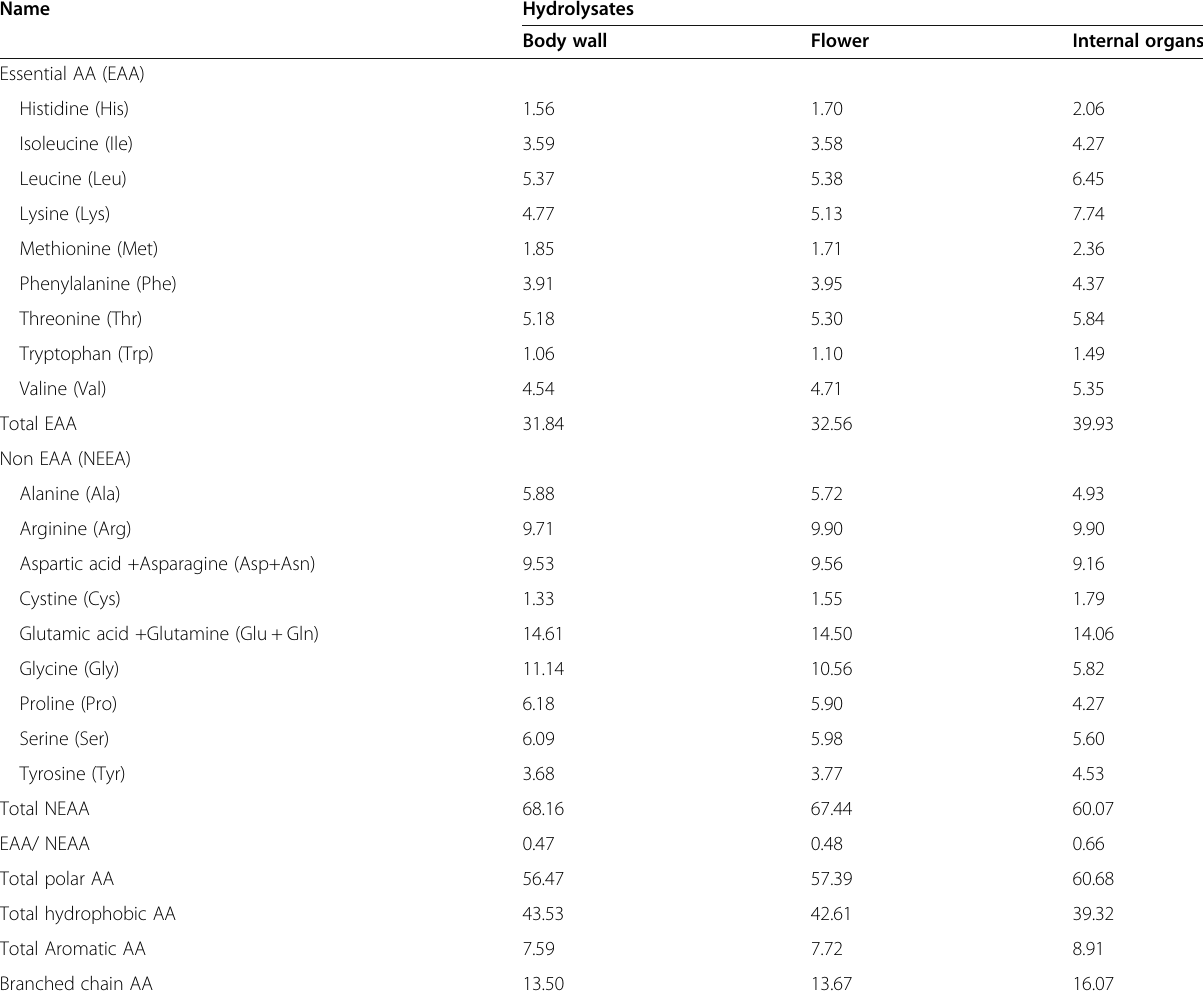
Table 3 Amino acid composition of protein hydrolysates (Alcalase+Flavourzyme) from different body parts of the North Atlantic sea cucumber (Mole